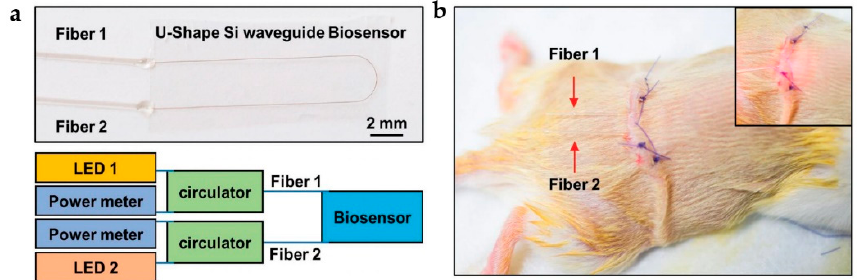
Figure 6. ( a ) Optical image of a transient silicon waveguide-based biosensor ( top ) and schematic illustration of the operating principles ( bottom ). ( b ) Optical image of a transient biosensor after the implantation into the subcutaneous region near the thoracic spine of a mouse model. The inset displays the optical image of a red light (wavelength: 660 nm) passing through the biosensor. ( a , b ) Reproduced with permission from [20].